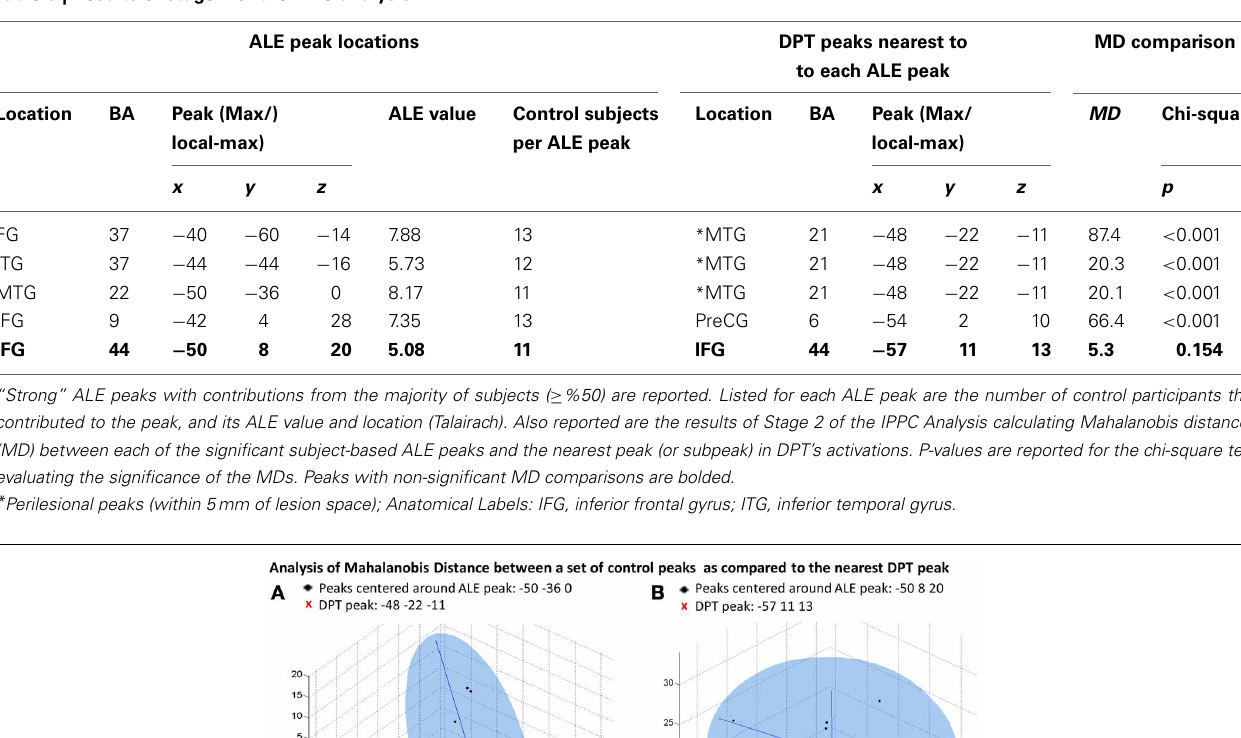
Table 5 | Results of stage 2 of the IPPC analysis.